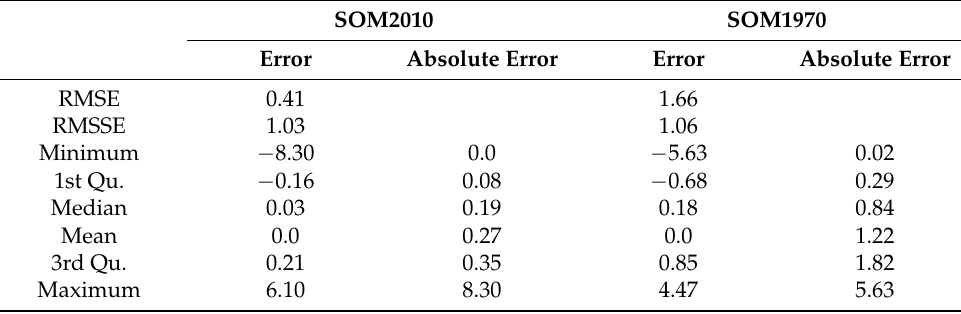
Table 2. Cross-validation diagnostics for SOM2010 and SOM1970 datasets.